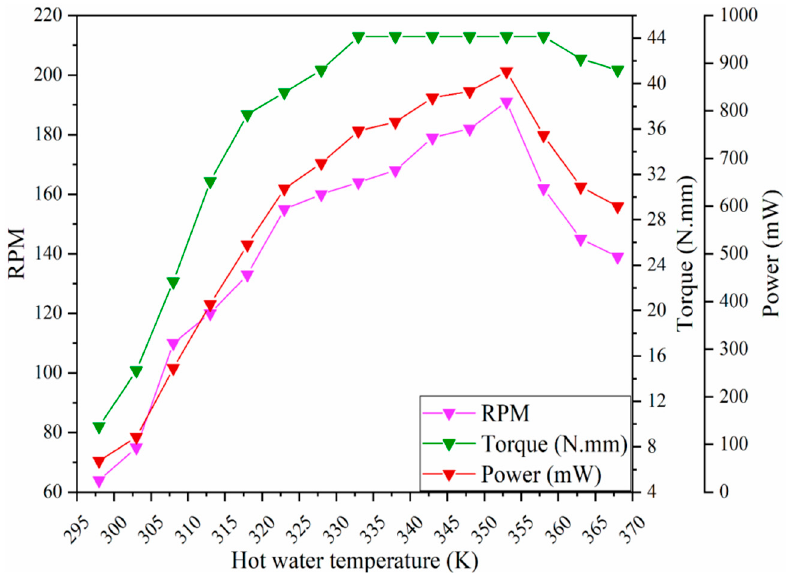
Figure 2. Magnetic flux density around the heat engine.